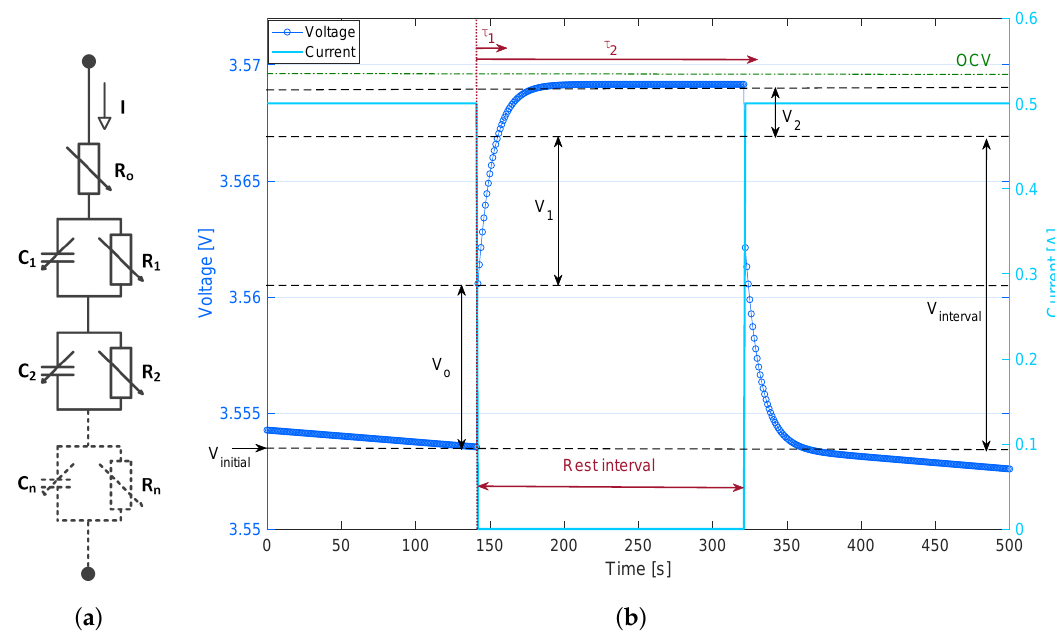
Figure 2. An example of voltage relaxation during rest interval in discharge with corresponding circuit elements. ( a ) The electrical circuit elements; ( b ) The voltage relaxation